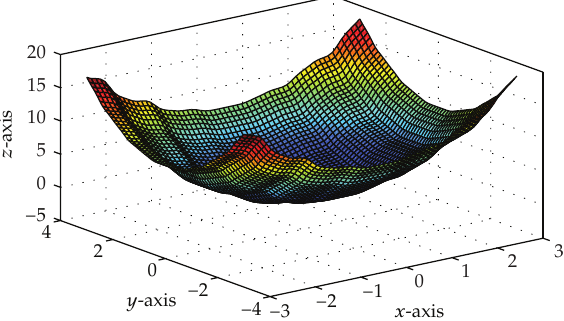
(cid:28) β j (cid:8) 3 , (cid:28) γ j (cid:8)